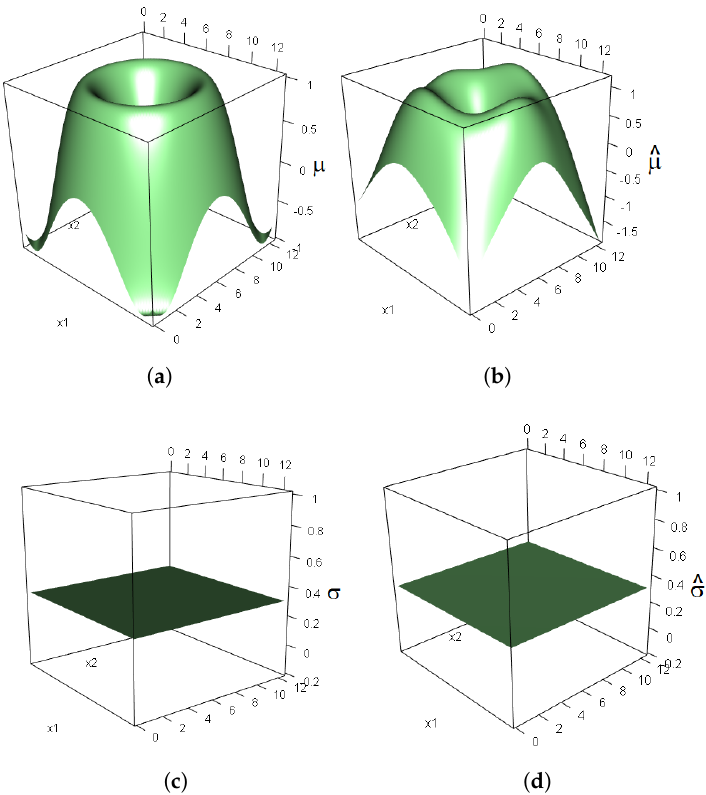
Figure 2. Real functions ( a , c ) and functions obtained by fitting the parameters ( b , d ) of a non-stationary generalized extreme value (GEV) model to simulated data with a sample size of n =